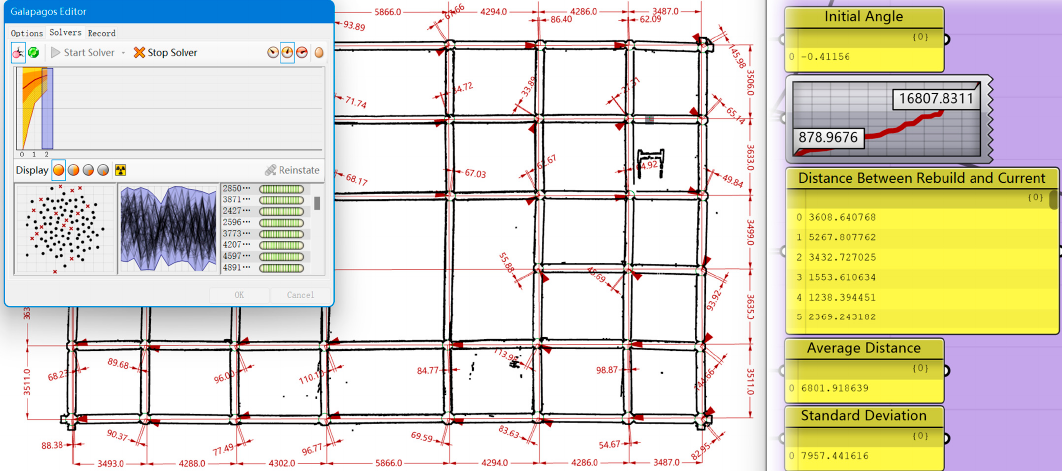
Figure 8. The beginning of the solution process and numerical analysis of this moment.